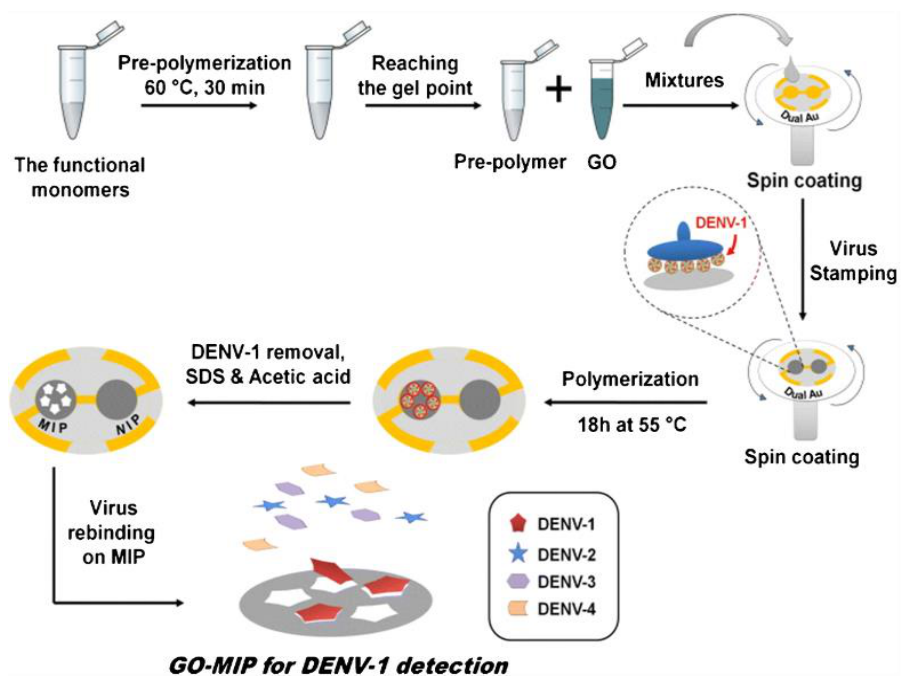
Figure 2. Schematic representation of GO-MIP and corresponding GO-NIP synthesis and their layer fabrication on QCM for detecting DENV-1. Reused with permission from Springer Nature [74].